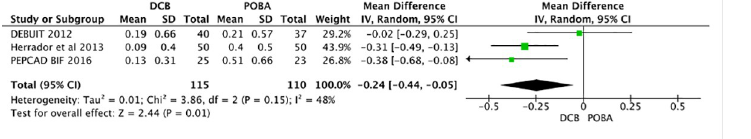
was a high bailout stenting rate of 45%.